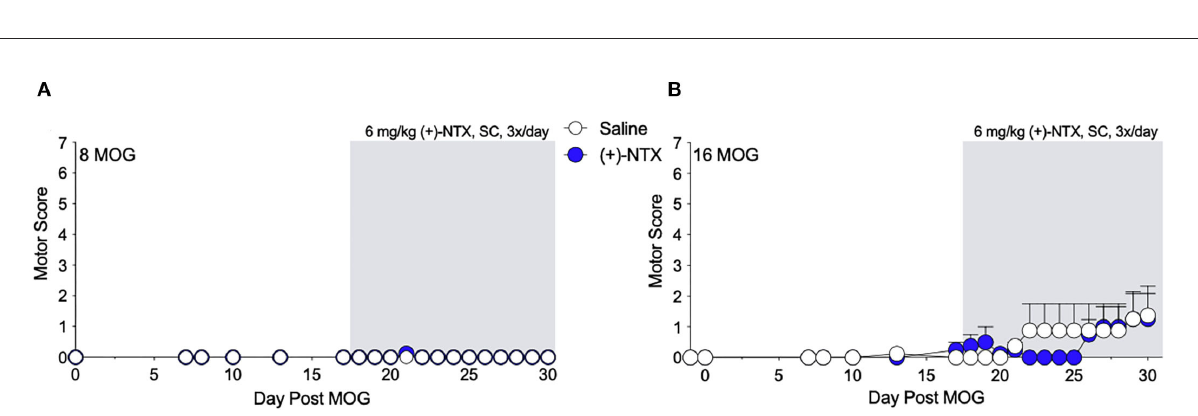
FIGURE3 Daily systemic administration of the TLR2–TLR4 antagonist ( + )-Naltrexone [( + )-NTX] does not alter EAE motor scores in Sprague-Dawley (SD) rats. Sprague-Dawley (SD) rats were baselined (BL) for motor scores followed by intradermal low-dose (0, 8, and 16 µ g) myelin oligodendrocyte glycoprotein (MOG). ( + )-NTX [6 mg/kg subcutaneously (SC) 3x/day] vs. saline was initiated on day 17 post-MOG, continuing through day 30 (see gray rectangle indicating span of drug delivery), and motor scores were assessed thereafter across the timecourse shown. (A,B) No dose of MOG reliably increased motor scores. ( + )-NTX did not alter motor scores. N = 8/group.